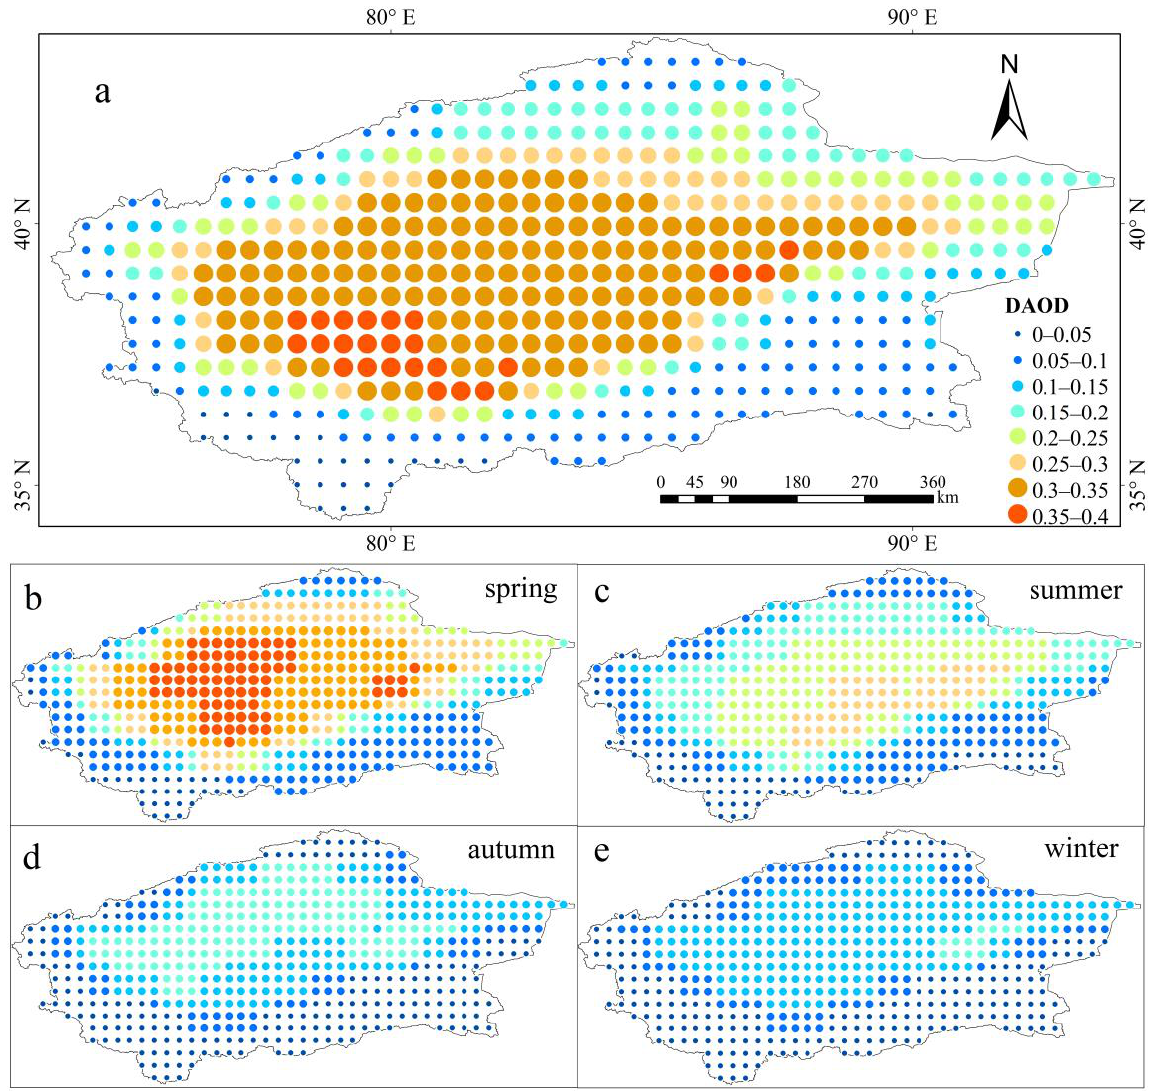
Figure 8. Spatial Distribution of DAOD in Tarim Basin from 1989 to 2021, ( a ): Multiyear average DAOD; ( b – e ): DAOD in different seasons.